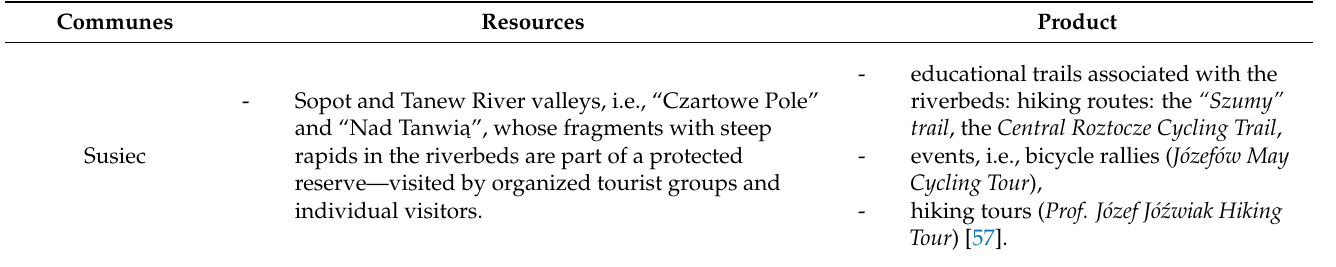
Table 13. Communes with a high value of the total geotourism function index (TGFI = 0.123–0.183).